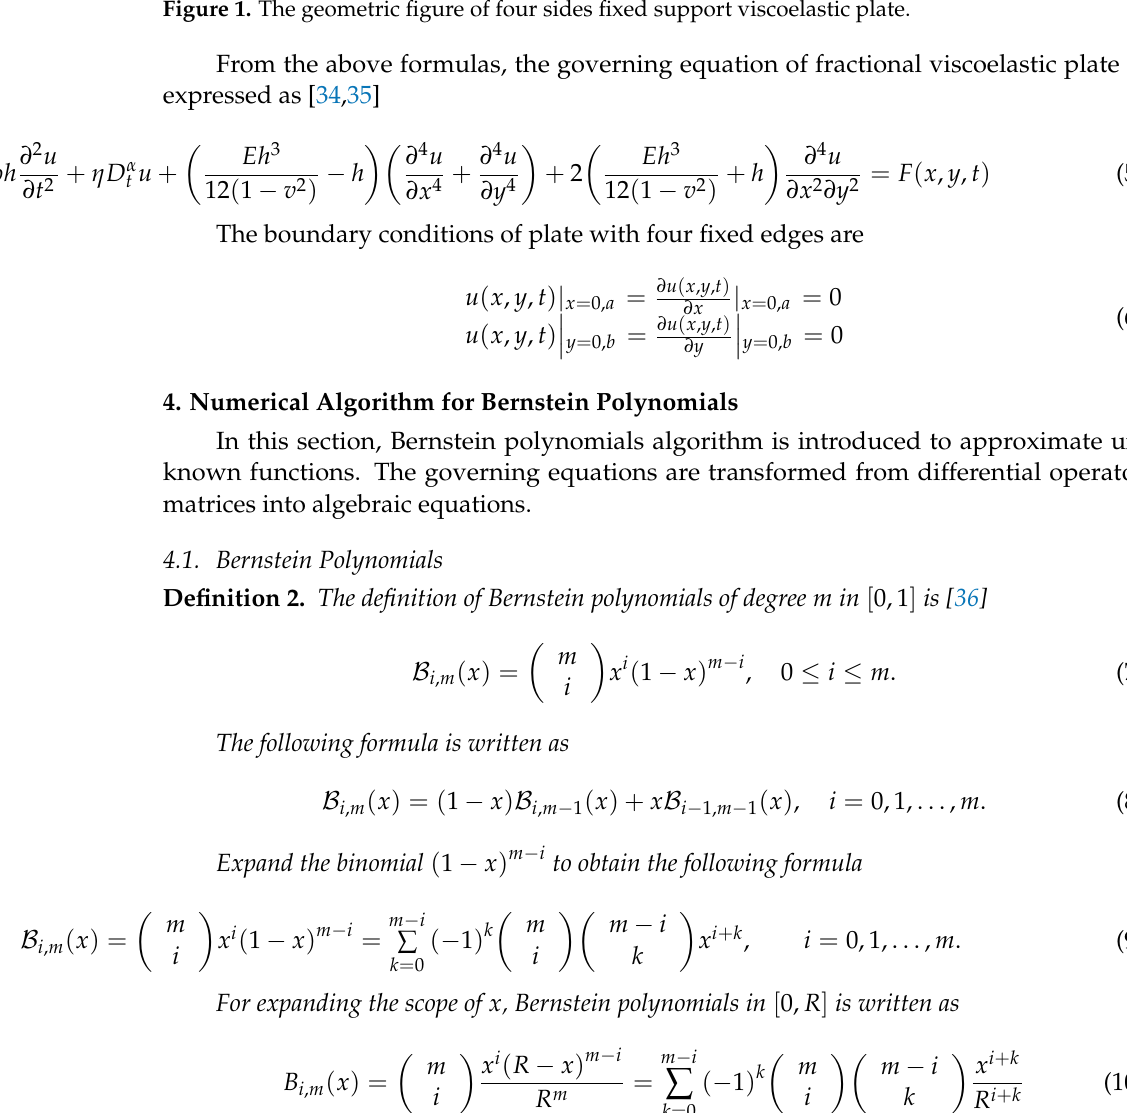
Figure 1. The geometric figure of four sides fixed support viscoelastic